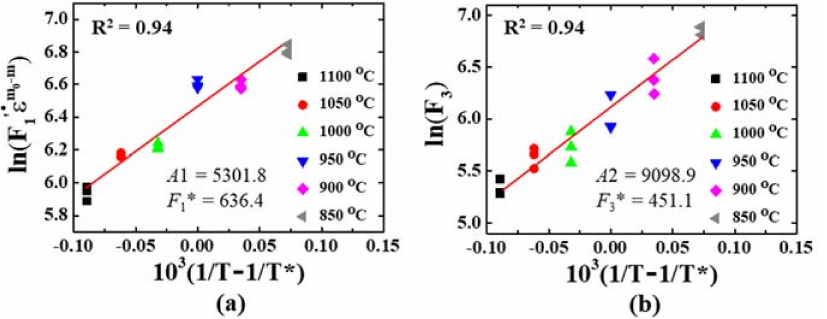
(cid:16) . − m (cid:17) F 1 (cid:48) ε m 0 and ( b )